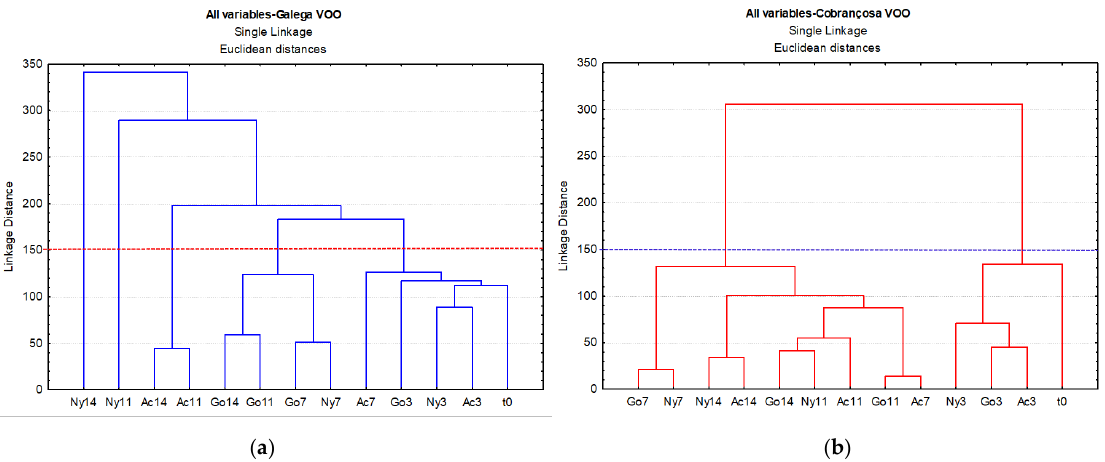
Figure 8. Dendrograms of Galega ( a ) and Cobrançosa VOO ( b ) samples obtained from fruits inoculated with C. acutatum (Ac), C. nymphaeae (Ny), and C. godetiae (Go), at times 0, 3, 7, 11, and 14 d.p.i., characterised by all the variables considered in Figure 7.